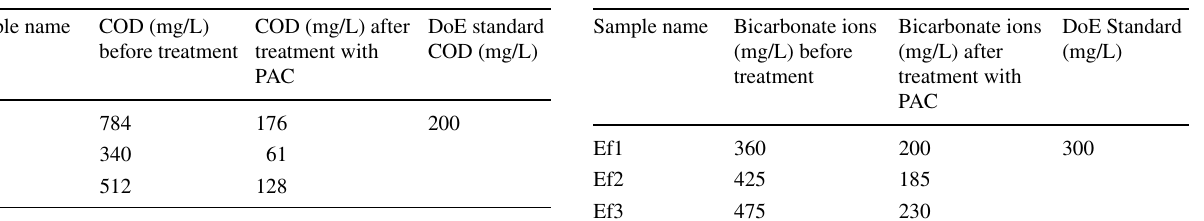
Table 6 Chemical oxygen demand (COD) of textile effluents